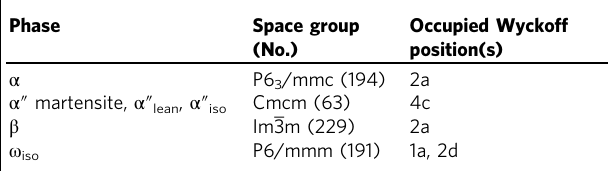
Table 2 Space group and Wyckoff position(s) for each phase used for the re fi nements Phase Space group